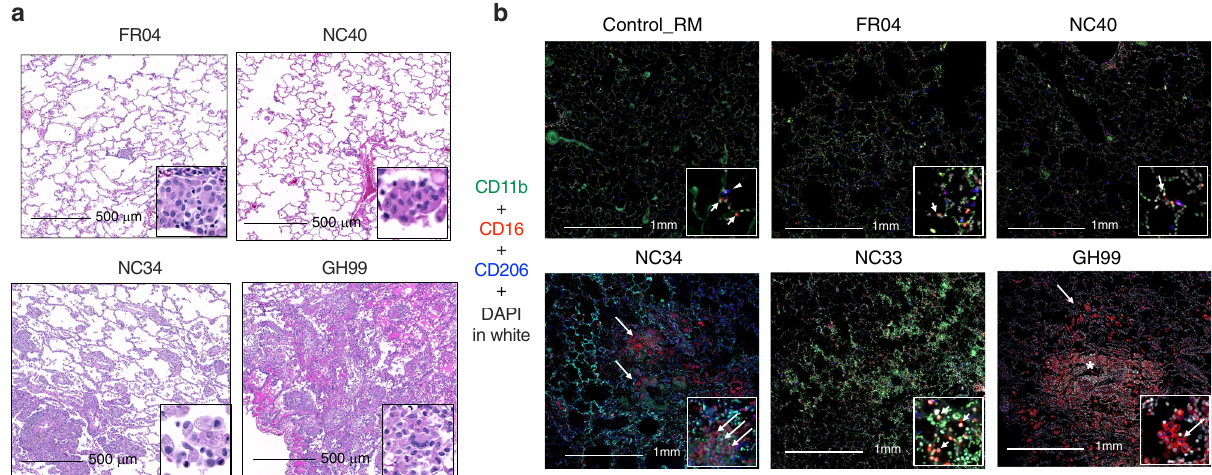
Fig. 3 Interstitial macrophages are increased in the lung of SARS-CoV-2 infected animals. a Macrophage in fi ltration varied from minimal to severe in both rhesus and AGM infected with SARS-CoV-2. b Fluorescent immunohistochemistry in the lung of AGM and RM showing in fi ltration of CD16 + CD11b + CD206 − macrophages (arrows), with lesser numbers of CD16 + CD206 + macrophages (arrowheads). Inset showing a higher magni fi cation of CD16 + CD11b + CD206 − macrophages (arrows). Asterix shows macrophages multifocally surrounding small airways in GH99. White: DAPI (nuclei); green: CD11b; red: CD16; blue: